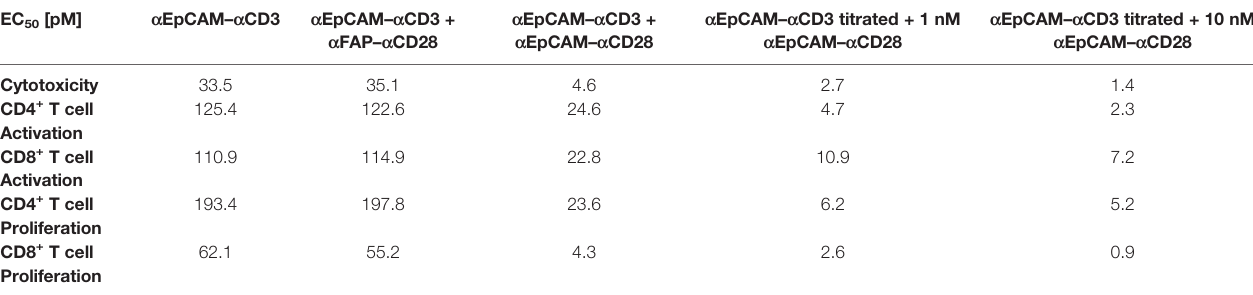
TABLE 1 | EC 50 values of stimulatory and co-stimulatory BiMAb in functional T cell assays. EC 50